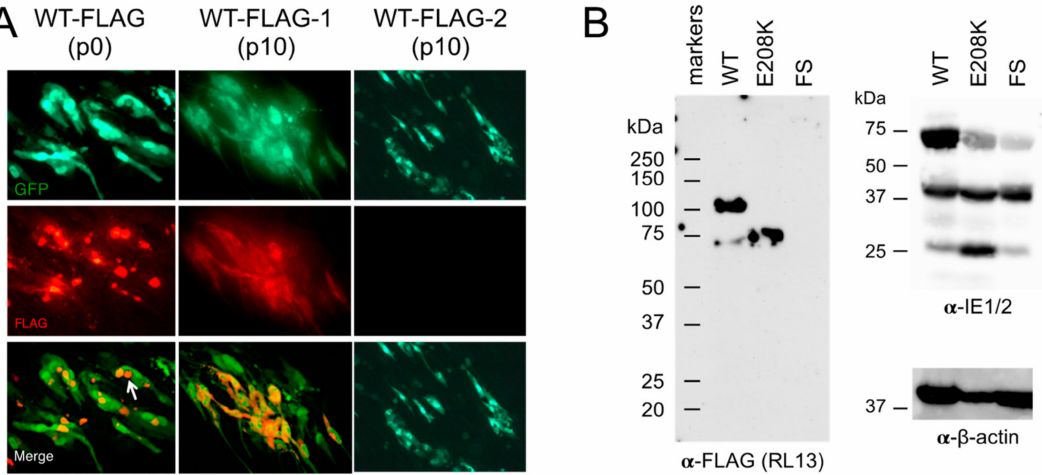
Figure 4. Detection and localization of RL13-FLAG expressed by virus TL12-RL13 WT-FLAG . ( A ) MRC-5 cultures were infected with a p0 stock of TL12-RL13 WT-FLAG or with p10 stocks of TL12-RL13 WT-FLAG–1 or TL12-RL13 WT-FLAG–2 . At day eight post-infection, cultures were stained for FLAG, and images of the FLAG (red) and GFP (green) signal were acquired. The white arrow indicates RL13 WT-FLAG accumulation into juxtanuclear structures corresponding to the VAC. Original magnification: 100 × . ( B ) MRC-5 cultures were infected with p0 stocks of TL12-RL13 WT-FLAG , TL12- RL13 E208K-FLAG , or TL12-RL13 FS-FLAG . Cell lysates prepared at day five post-infection were separated by SDS-PAGE, transferred to a nitrocellulose membrane, and probed using α -FLAG, α -IE1/2, or α - β -actin monoclonal antibodies. The positions of protein molecular weight standards are